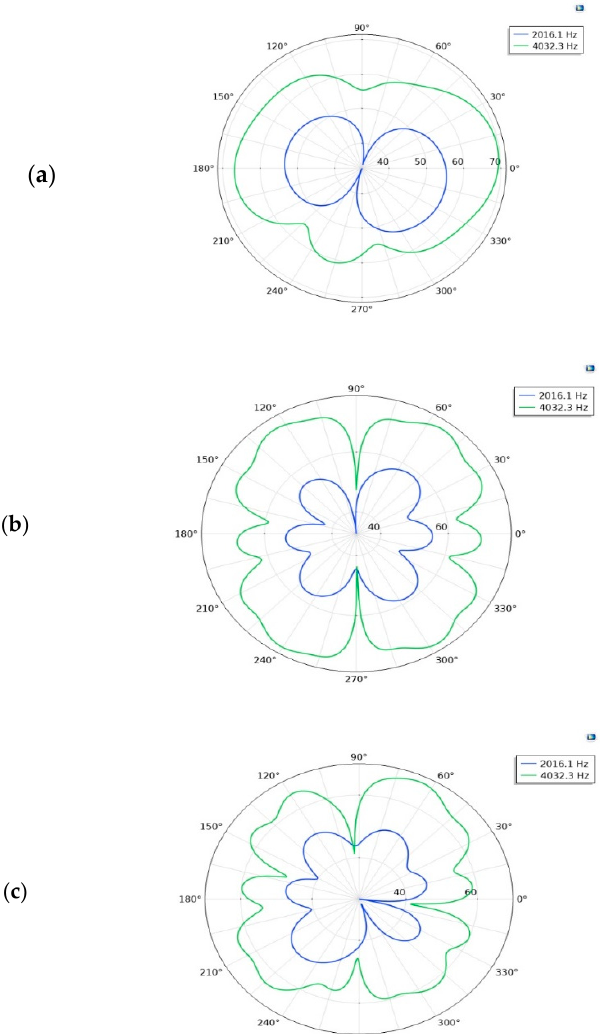
Figure 10. Far-field sound pressure level in dB at a distance of 1 m in the ( a ) x - y plane, ( b ) x - z plane, and ( c ) y - z plane .